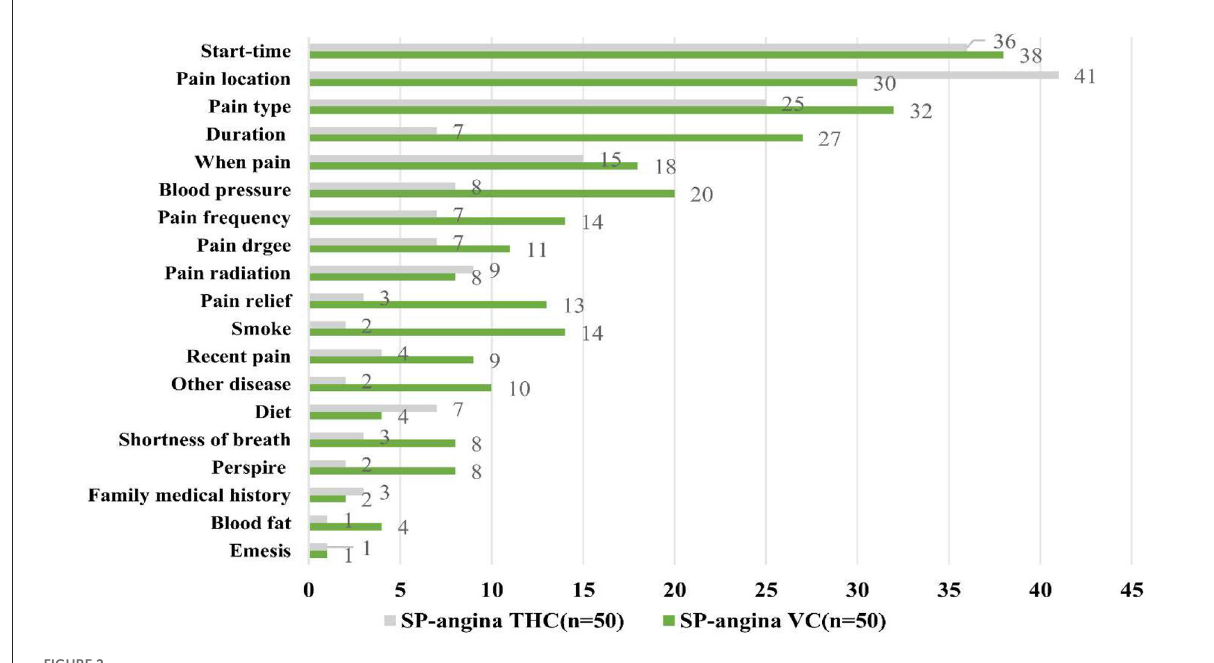
FIGURE2 Adherence to clinical checklist, angina case.